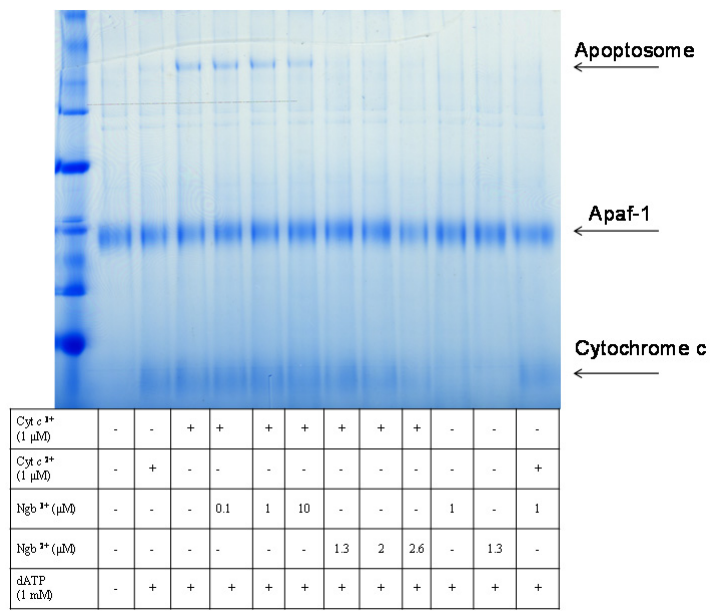
Figure 3. Native blue gel showing Apaf-1 binding to oxidized cytochrome c in the presence of ATP to give the apoptosome